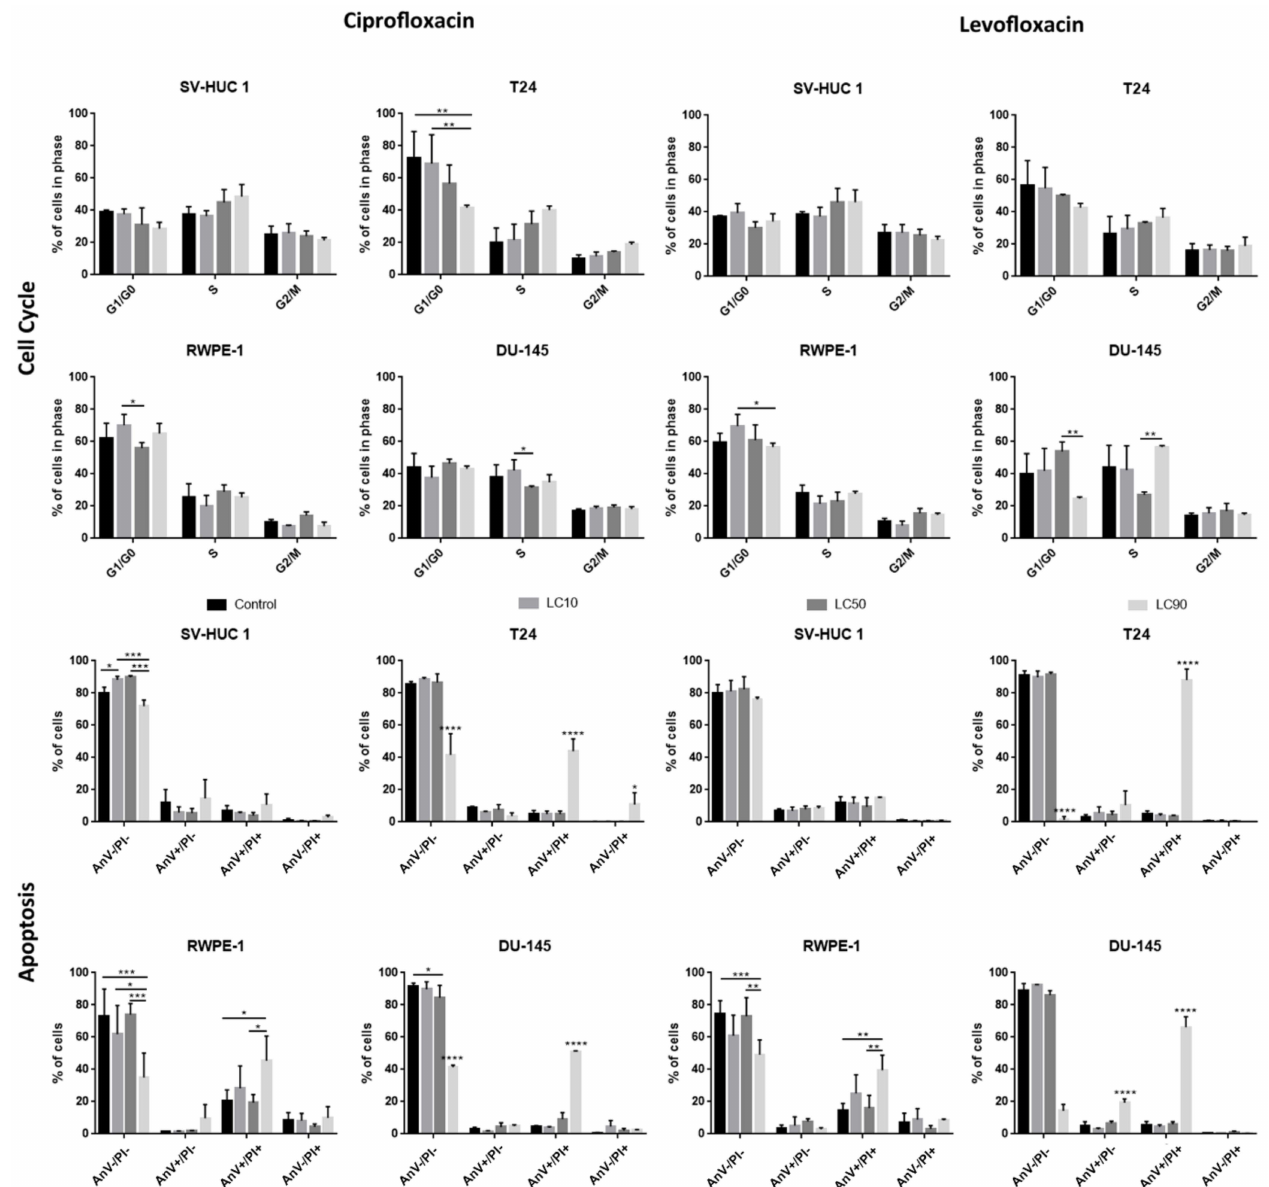
Figure 5. Cell cycle and apoptosis analysis. Both drugs caused a rise of cells number in the S phase, especially after treatment with LC90 concentrations. After levofloxacin treatment in bladder cancer cells, an increased number of cells in the G2/M phase was also observed. Apoptosis analysis revealed an increased number of late apoptotic/necrotic/dead (AnV+/PI+) cells after incubation of tested cells with both fluoroquinolones in LC90 concentration. AnV-/PI-: alive; AnV+/PI-: probably early apoptotic; AnV+/PI+: dead/late apoptotic/necrotic; AnV-/PI+: membrane-free nuclei, where with a decrease in PI signal, the degradation of genetic material is observed; SV-HUC-1—non-malignant human urothelium; T24—human bladder cancer; DU-145—human prostate cancer; RWPE-1—non-malignant human prostate epithelium; *— p ≤ 0.05; **— p ≤ 0.01; ***— p ≤ 0.001; ****— p ≤